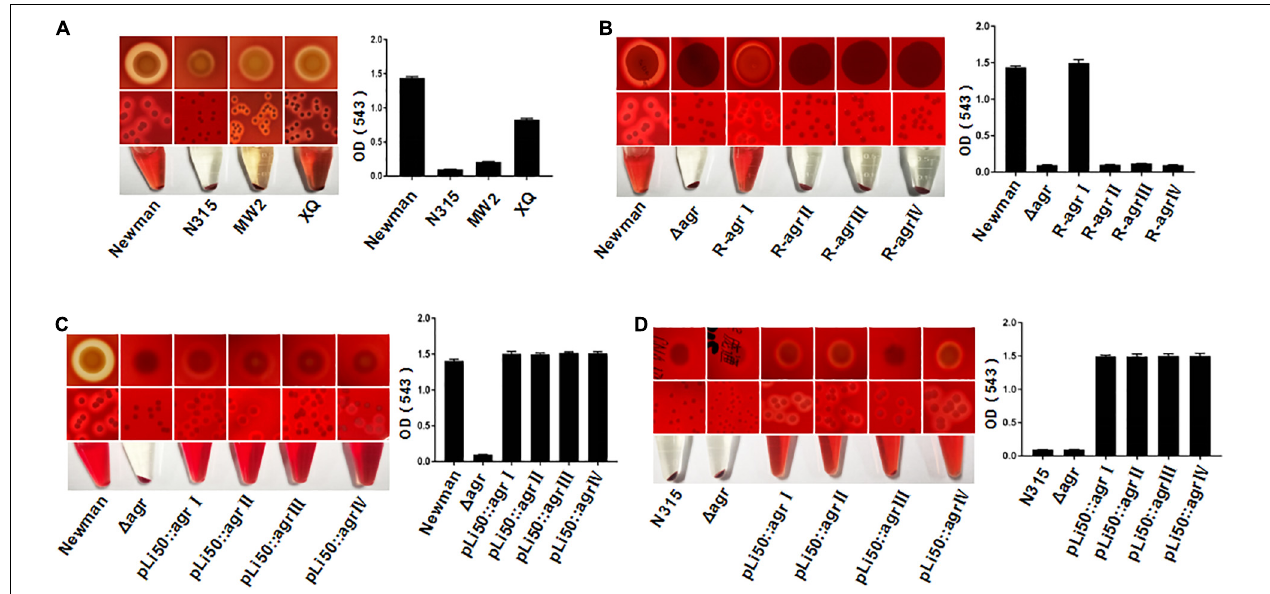
FIGURE 2 | Effects of agr alleles on the hemolytic activities of S. aureus . The overnight cultures of S. aureus strains with the same CFUs were plated on Columbia blood agar plates and grown for 24 h at 37 ◦ C. (A) Hemolytic activities of the four wild agr allelic strains: agr I (Newman), agr II (N315), agr III (MW2), and agr IV (XQ). (B) Hemolytic activities of the wild Newman strain, Newman (cid:49) agrBDC , and agr genomic in situ replacement mutants of Newman ( agr I to agr IV). Hemolytic activities of the wild type, (cid:49) agrBDC mutants and pLI50- agr plasmid complement mutants of Newman (C) and N315 (D) . The hemolytic activities of the relative strains were determined by measuring the optical density